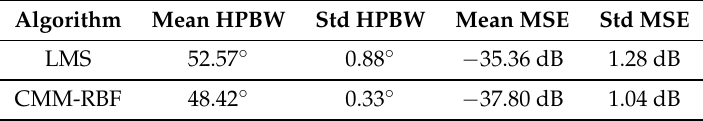
Table 2. Half-power beamwidth (HPBW) and mean squared error (MSE) statistical results for the 2D-grid array, varying the boresight angle from 0 ◦ to 360 ◦